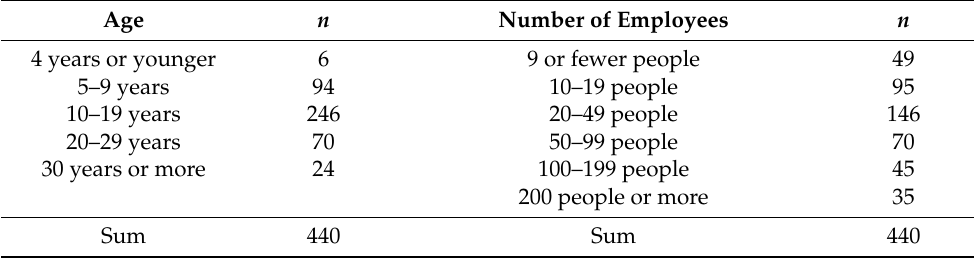
Table 2. Distribution of firms by the age and the number of